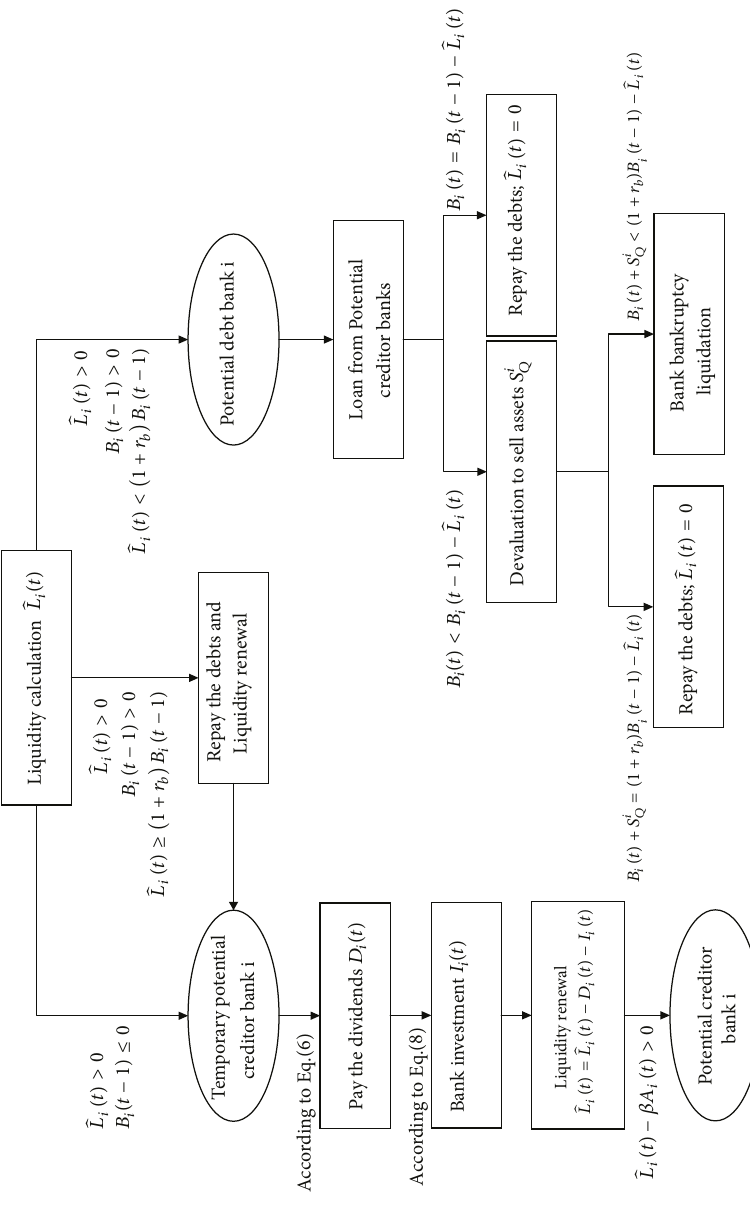
Figure 2: The dynamic process of bank 𝑖